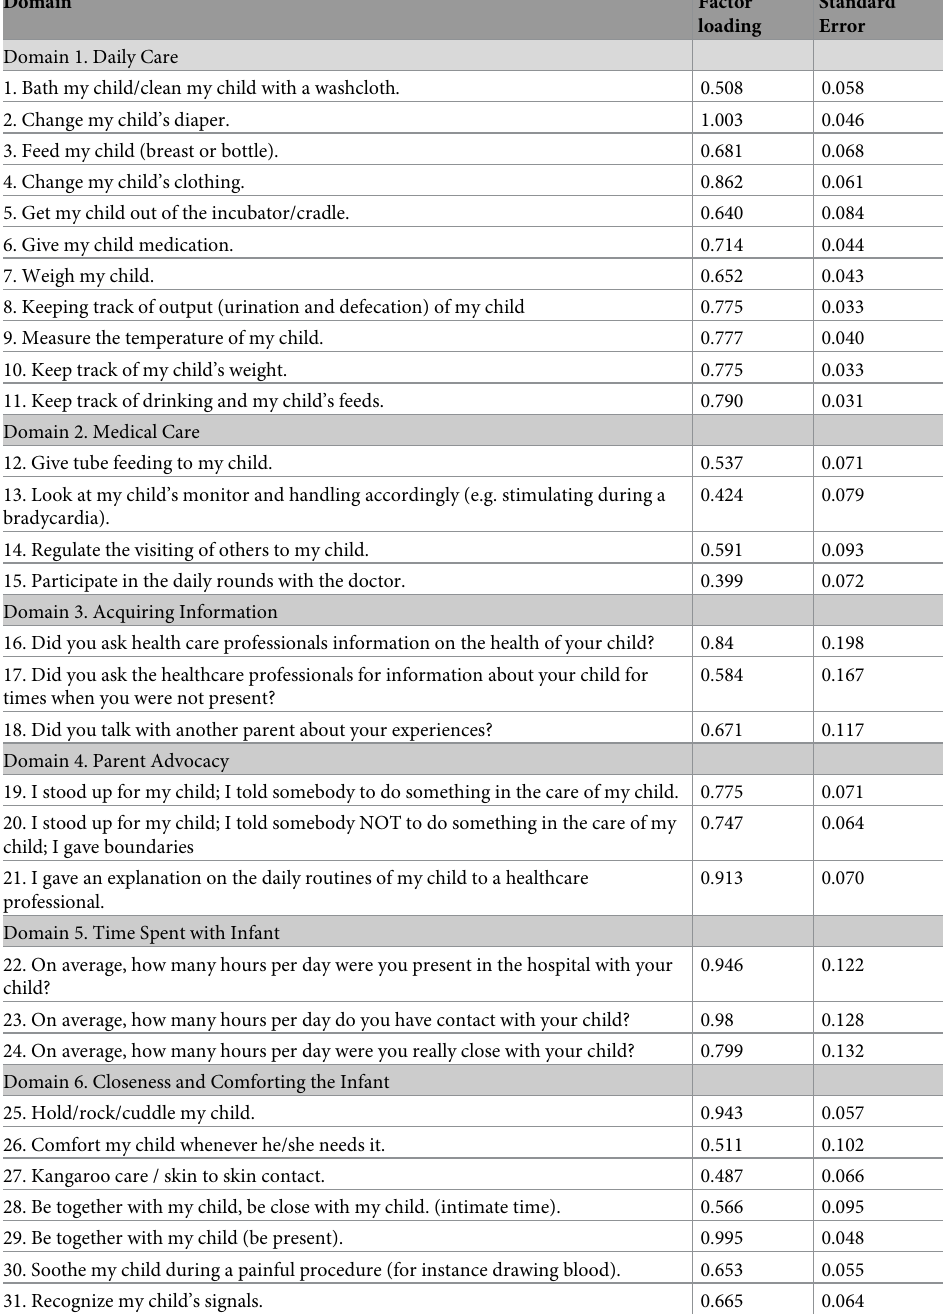
Table 3. Factor loadings after confirmatory factor analysis. Domain Factor